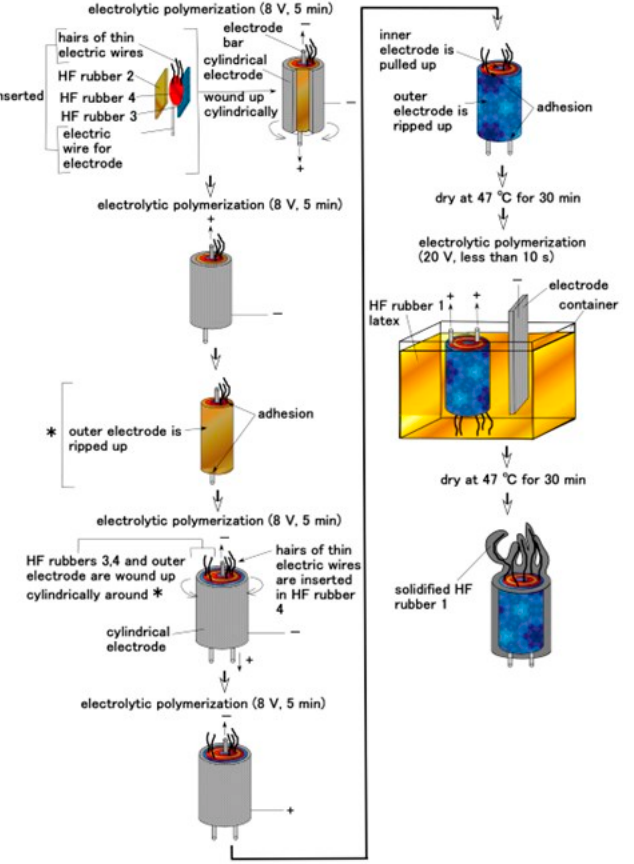
Figure A1. Fabrication process of cylindrical-type Pacinian corpuscles for gustatory receptor [23].